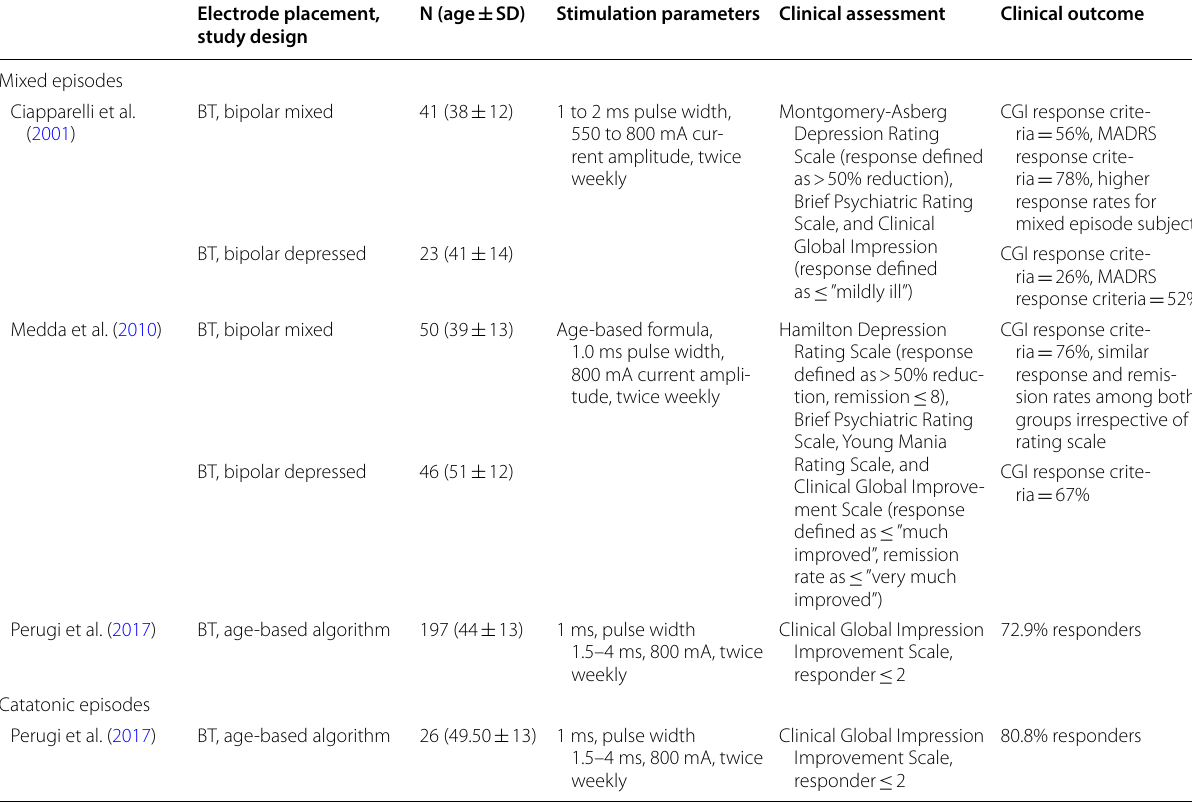
Table 3 Electrode placement and bipolar mixed and bipolar catatonia Electrode placement, study design